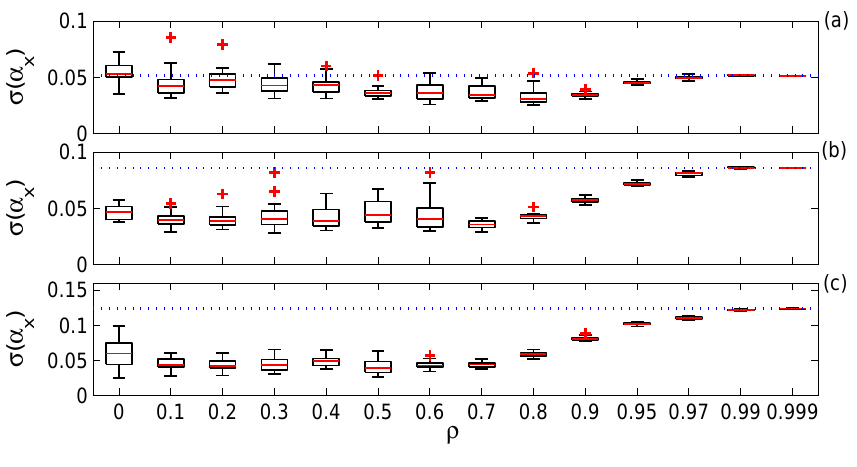
Fig. 15. Gradual wavelet reconstruction of multifractional Brownian motions given by Eq. (16) with f = 0 . 005 (a) , f = 0 . 010 (b) , and f = 0 . 015 (c) . The metric employed is the standard deviation of the calculated H¨older